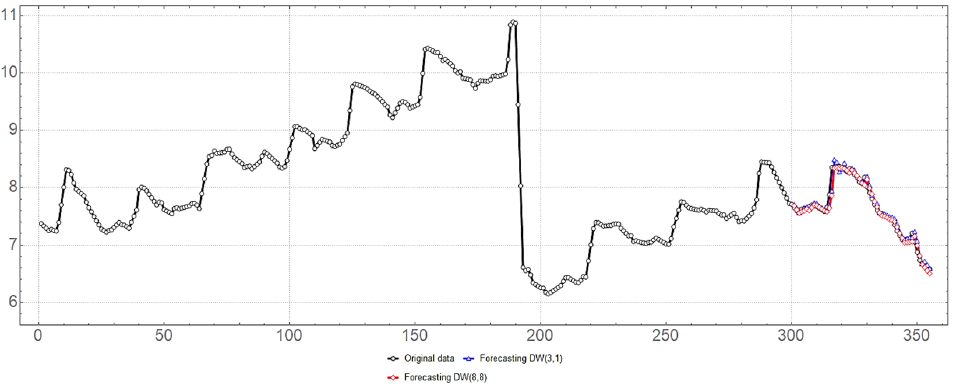
Figure 7. Correlation between the value of the original time series (daily cash balances in the 2019 federal budget TSA) (black) and predicted values based on DW [3.1] (blue) and DW [8.8] (red) transformations. Source: authors’ calculations.